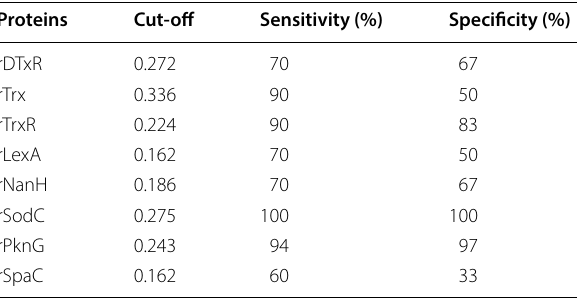
curve analysis with indirect ELISA results using positive